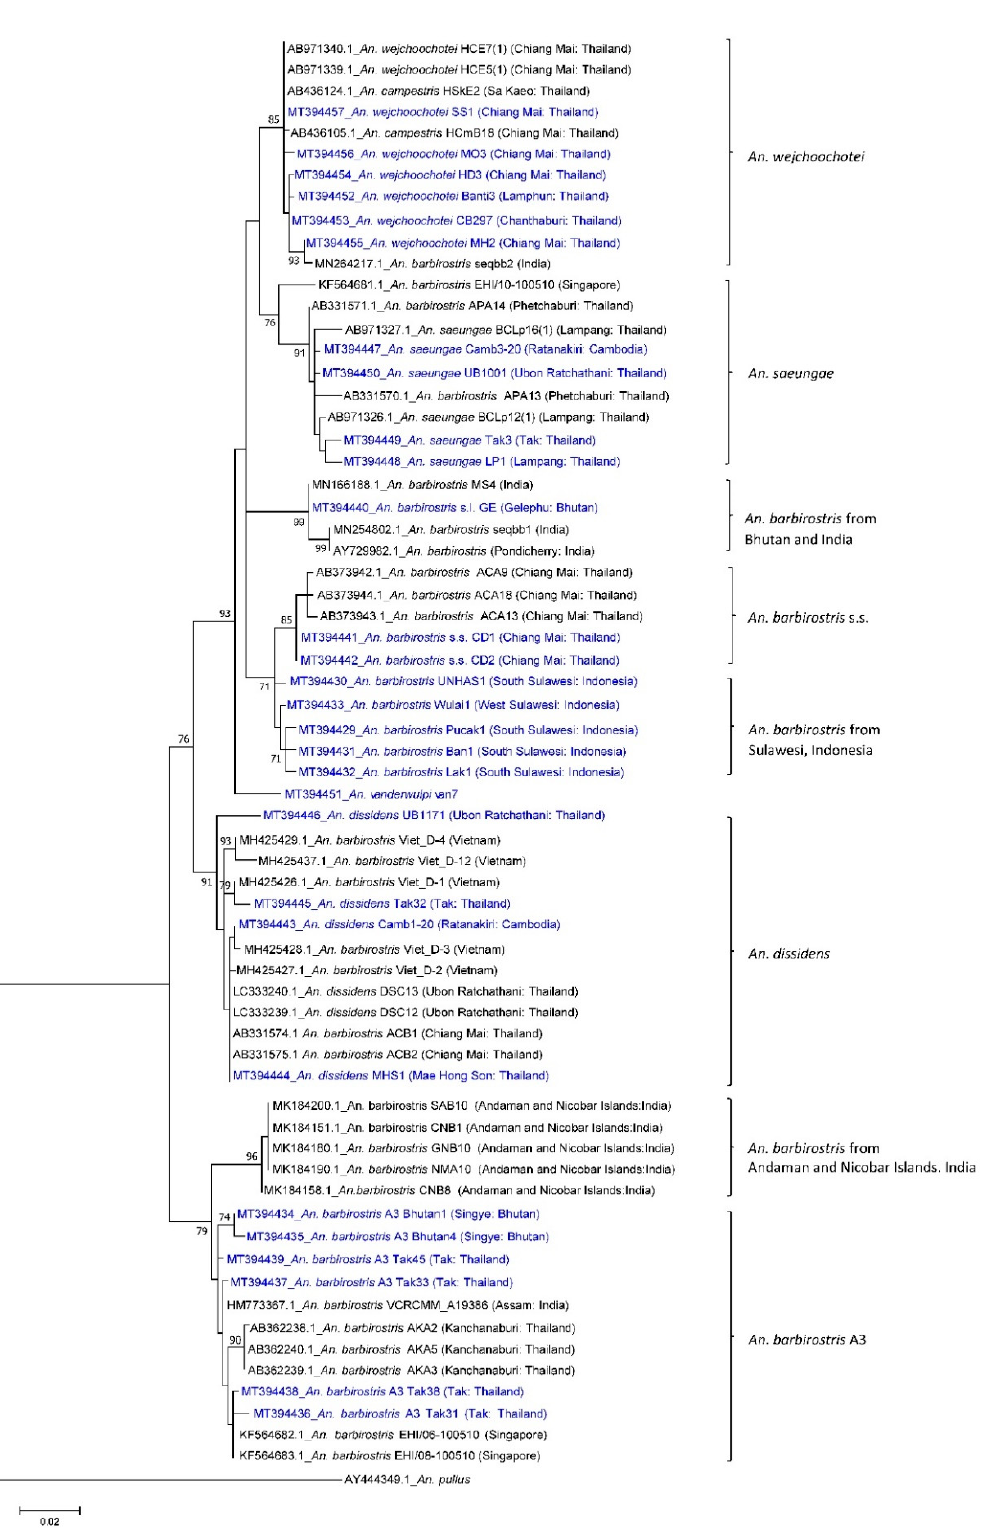
Figure 1. Maximum likelihood tree of COI sequences. Representative specimens of An. barbirostris s.l. in the current study are highlighted in blue. GenBank sequences included specimens from the Andaman and Nicobar Islands, India, Singapore, Thailand and Vietnam, and An. pullus as the outgroup. Bootstrap values of ≥ 70% are shown.